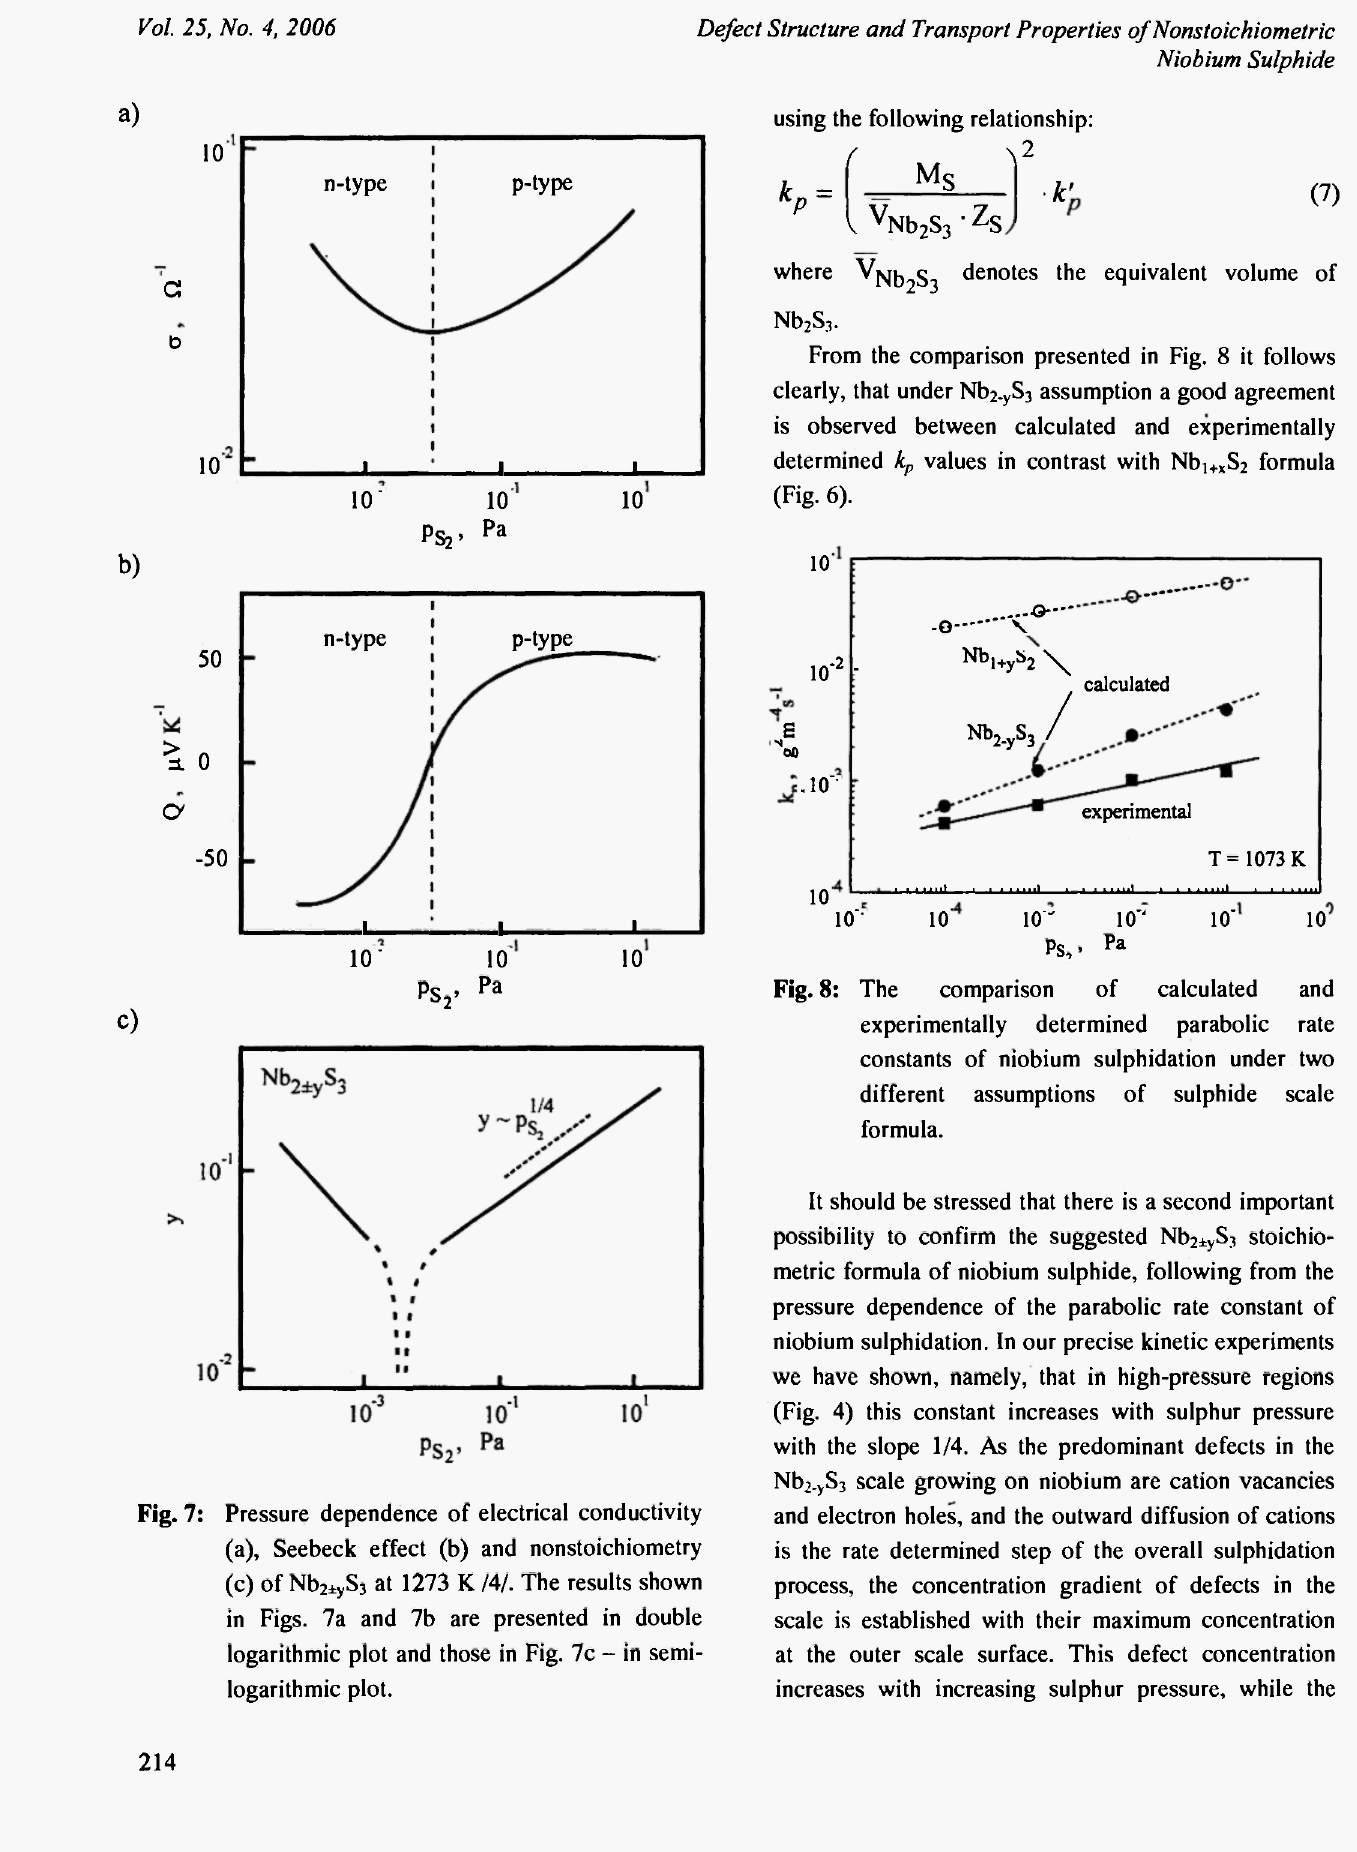
Fig. 7: Pressure dependence of electrical conductivity (a), Seebeck effect (b) and nonstoichiometry (c) of Nb 2±y S 3 at 1273 Κ IM. The results shown in Figs. 7a and 7b are presented in double logarithmic plot and those in Fig. 7c - in semi- logarithmic plot.